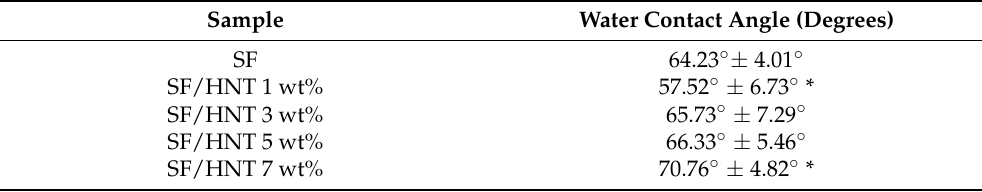
Table 2. Static contact angles of SF scaffolds and SF/HNT composite